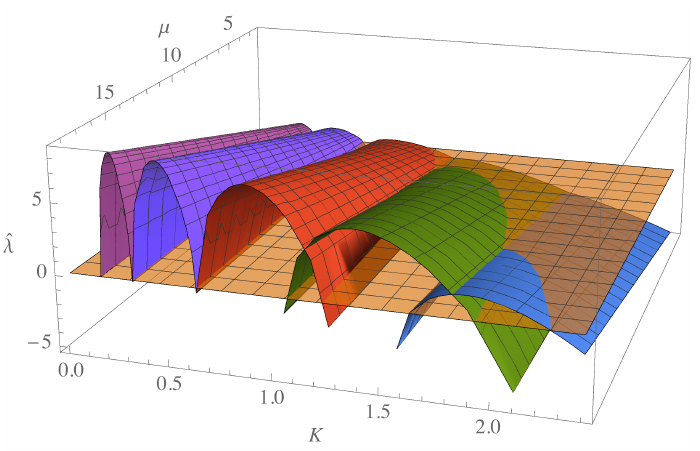
Figure 1. Dispersion relation (cid:98) λ ( K ) varying the parameter µ . Several values of the ratio between the interaction lengths are presented with different color plots; values increase to the left of (cid:96) = 2 (blue), (cid:96) = 3 (green), (cid:96) = 5 (red), (cid:96) = 10 (dark purple), and (cid:96) = 20